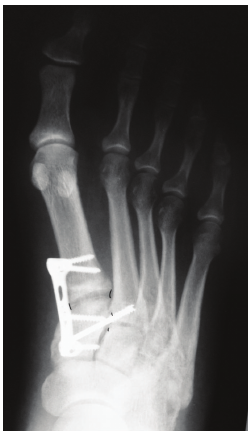
Figure 4: Initial postop. Rx showing congruency of the first two